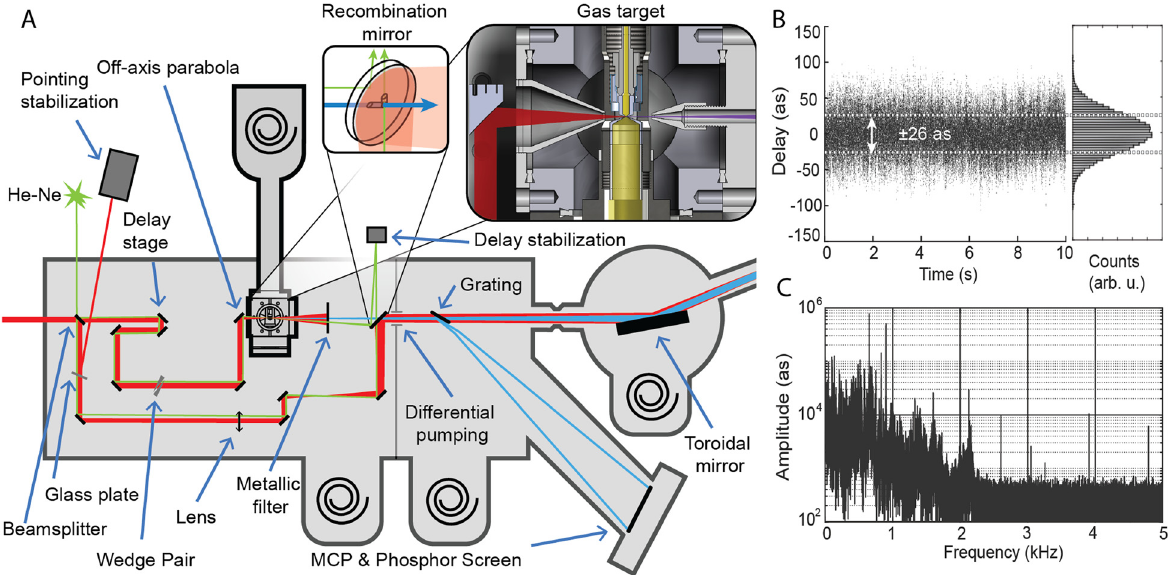
Figure 3: Extreme ultraviolet-infrared (XUV-IR) interferometer. (A)Interferometerbeampathandcomponents.Thenear-IRbeampathisshowninred,theXUVinblue,andaHeNe-laserwhichcanbeusedfor active delay stabilization is shown in green. (B) Stability measurement, showing the measured delay as a function of time; the root mean square is indicated in white (see the histogram plot on the right). (C) Single-sided amplitude spectrum of interferometer stability